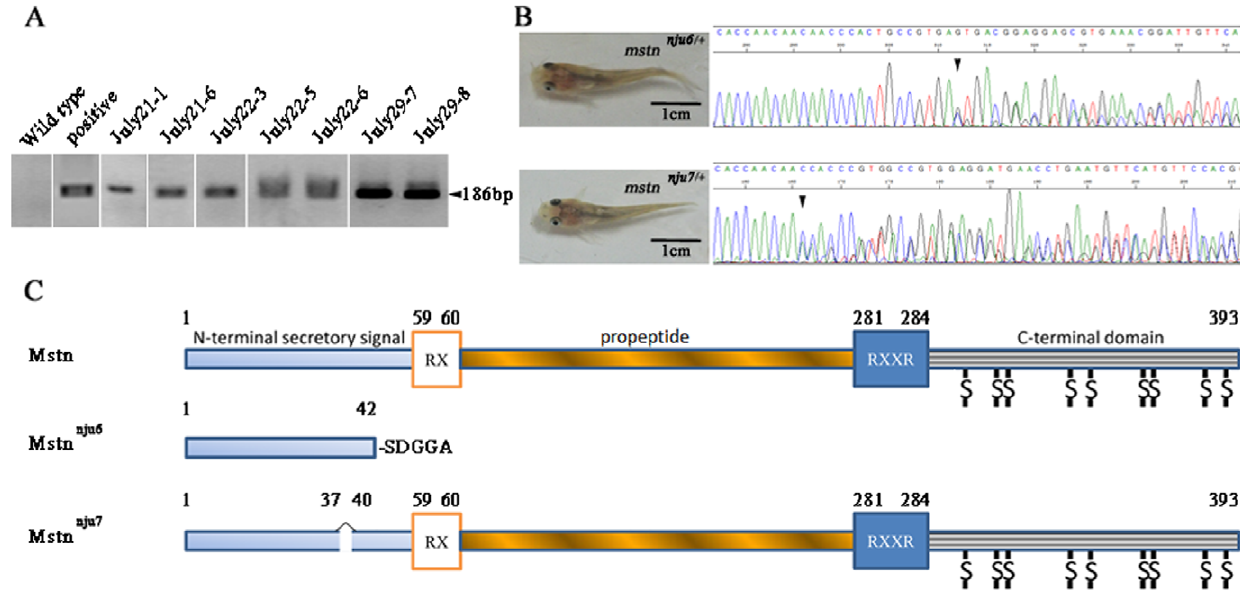
Figure 2. Generation of mstn knockout yellow catfish using engineered zinc finger nucleases. (A) 7 yellow catfish founders were identified to potentially carry mutated mstn in their germ cells by PCR. Agarose gel electrophoresis revealed that embryos from 7 yellow catfish founders gave out a predicted 186 bp product. The results suggested these fish carried a mutated mstn with the 4 bp insertion in their germ cells. ‘‘Wild type’’ and ‘‘Positive’’ denote the templates used for the 1 st round PCR were the genomic DNA isolated from a wild type yellow catfish (negative control) or the mutated mstn molecules with the 4 bp insertion (positive control), respectively. ‘‘July21-1, July21-6, July22-3, July22-5, July22-6, July29-7 and July29-8’’ denote the templates used for the 1 st PCR were the genomic DNA isolated from the different founders, respectively. (B) Sequencing chromatography shows the PCR products from two juvenile yellow catfish containing different mutated mstn alleles in their genomes. Arrow heads indicate that the mutated mstn alleles have different sequences from wild type allele stating from the base pointed. (C) Schematic diagram shows two mutated proteins would be produced from the two different strains of yellow catfish carrying different mutated mstn alleles. Mstn: Yellow catfish wild type Mstn comprises a signal sequence (N-terminal secretory signal), a propeptide domain (propeptide) and a bioactive domain (C-terminal domain). RX is a proteolytic site to remove the signal sequence and RXXR is a proteolytic processing site (RSSR) to produce bioactive form of Mstn. The number shows the position of amino acid residue [4]. Mstn nju6 : A truncated protein encoded by mstn nju6 contains only the 42 amino acid residues of the N-terminal secretory signal of yellow catfish Mstn plus 5 new amino acid residues. Mstn nju7 : A mutated protein encoded by mstn nju7 lacks two amino acid residues between aa37 and aa40 in the N-terminal secretory signal of yellow catfish